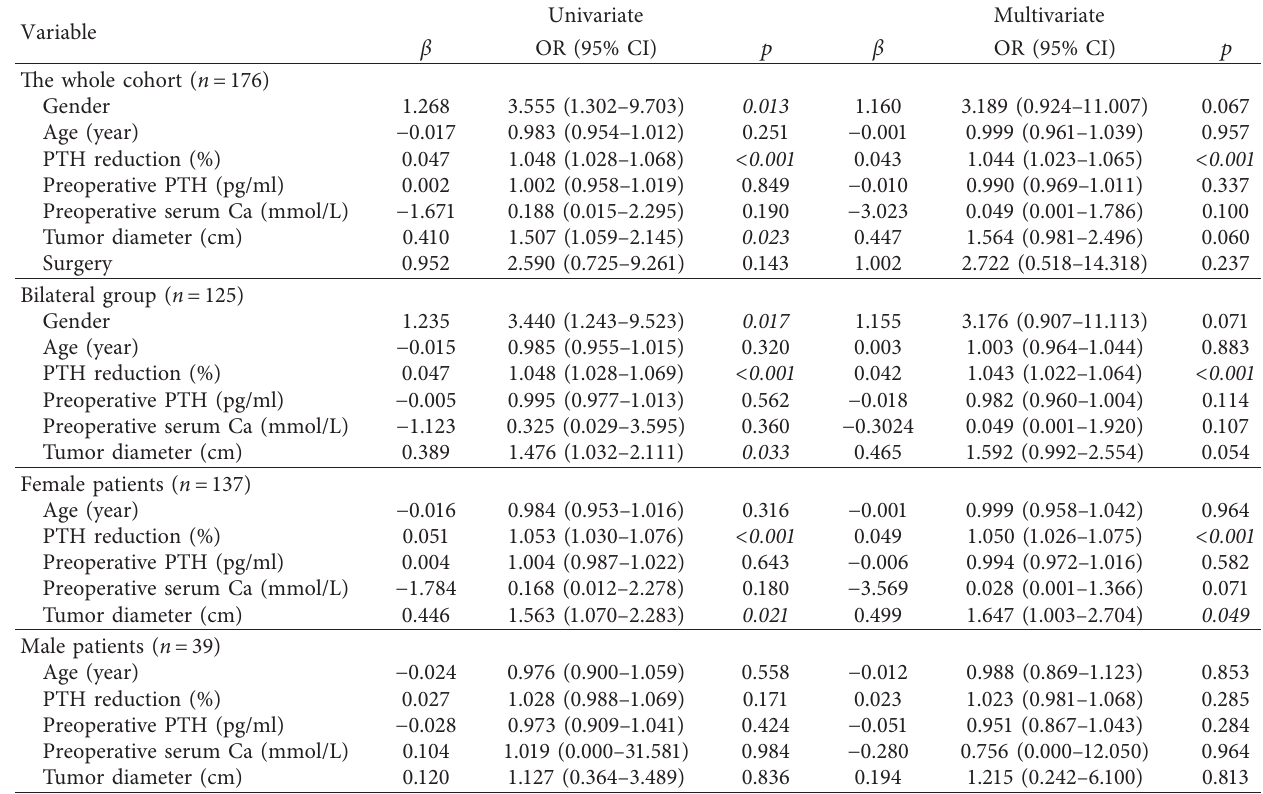
Table 4: The risk factors for the transient hypocalcemia on postoperative day